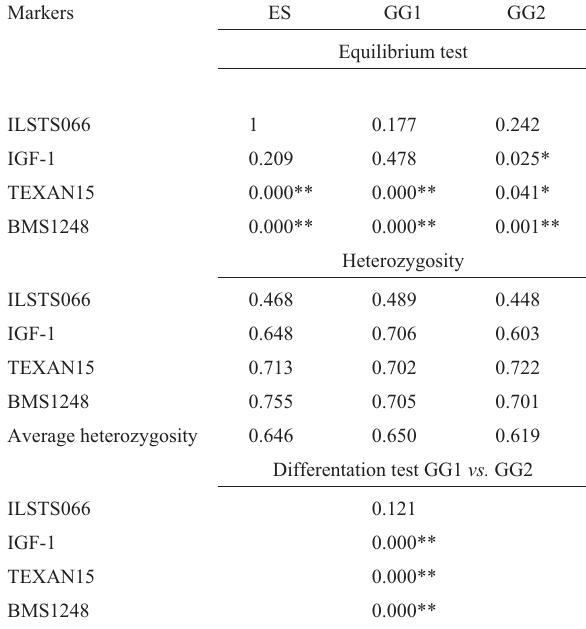
Table 2 - P-values for the equilibrium test, heterozygosity coefficients for the entire sample and within genetic groups, average heterozygosity for the loci in each sample, and P-values for differentiation test between genetic groups.